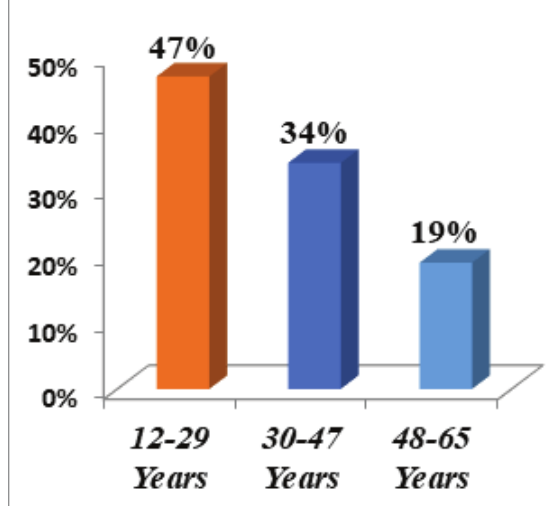
Figure 2: Distribution of patients according to